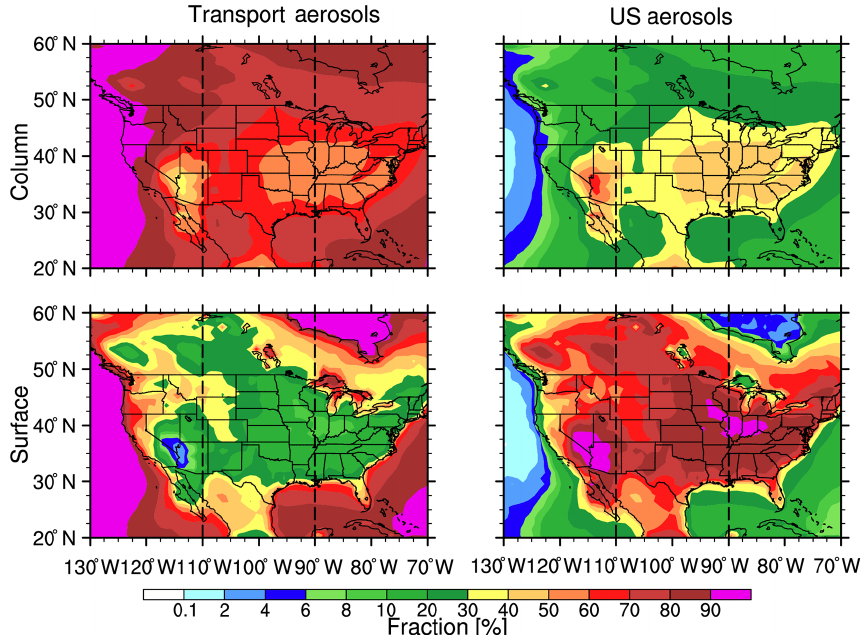
Figure 12. Spatial distribution of trans-Pacific transport and US total aerosol mass fraction for the column and at the surface from the WRF- Chem simulations averaged for 2010–2014. The North American region is divided into three subregions bounded by the dotted lines: west (20–60 ◦ N and 130–110 ◦ W), central (20 ◦ W–60 ◦ N and 110–90 ◦ W), and east (20–60 ◦ N and 90–70 ◦